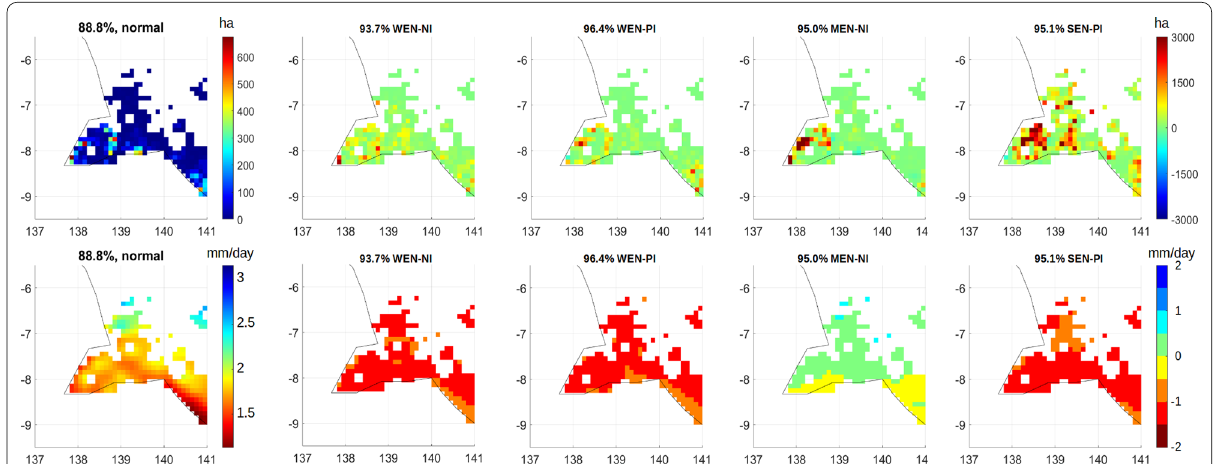
Fig. 4 Spatial of joint Pattern from each category on Merauke. In a normal graph, the colour represents an average of total burned area for each grid in the composite year only during fire season (July–December). Other categories represent the difference between each category with value